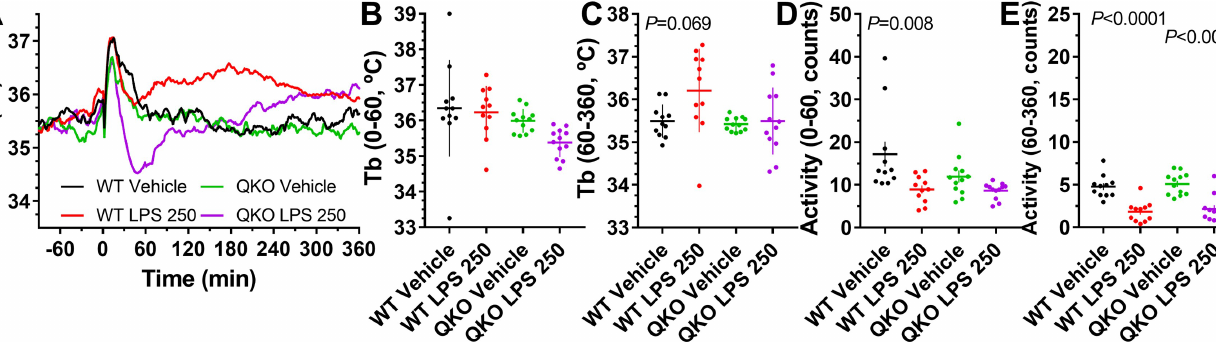
PLOS Biology | https://doi.org/10.1371/journal.pbio.3000161 March 1,